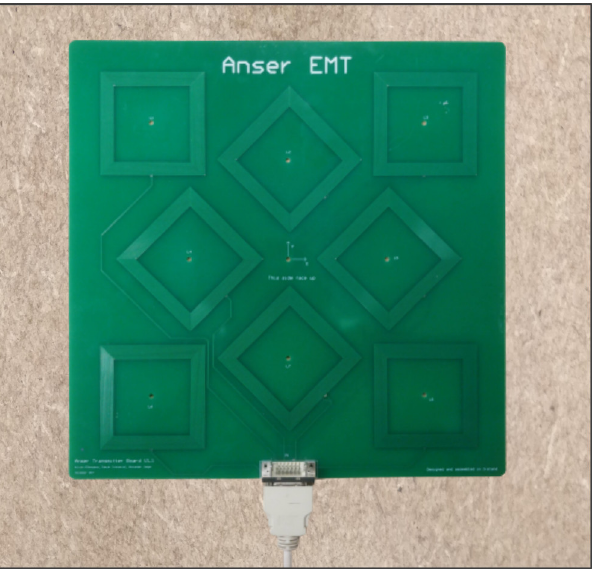
Figure 9. The field generator comprises a set of eight planar transmitter coils, as first presented in [12]. Each coil is driven with a sinusoidal current at a different frequency and the sensor coil uses frequency-division multiplexing (FDM) to distinguish the eight